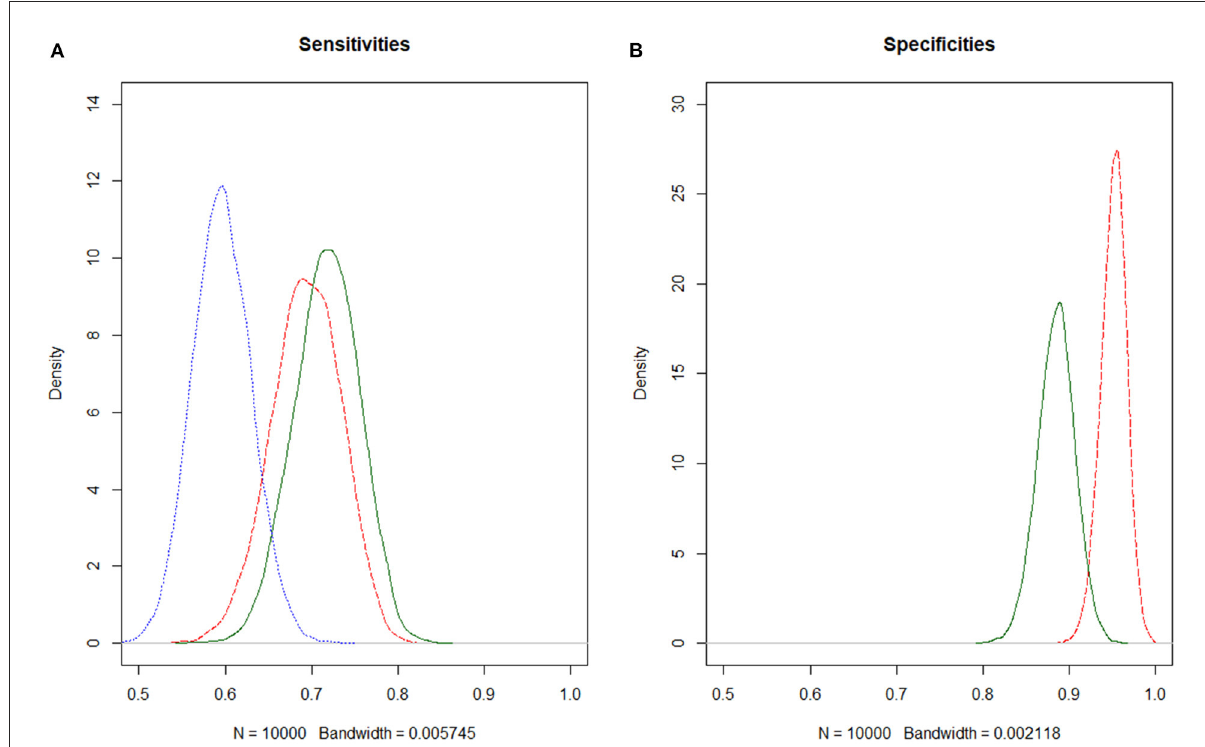
FIGURE1 (A,B) Estimating diagnostic test accuracies for S. uberis of Selma plus, Dipslide and culture, using Bayesian latent class models. Dipslide, red dashed; Selma plus, green solid; Culture, blue dotted. Since the specificity of culture in general is assumed to be very high, the specificity of culture was fixed to 1 in the